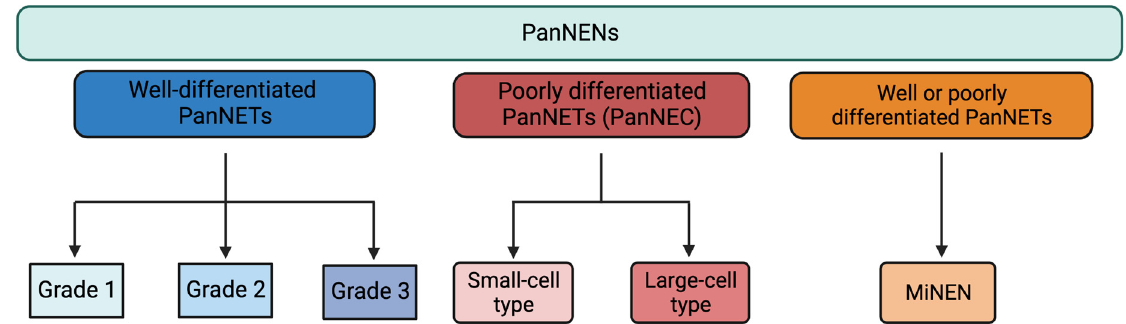
Figure 1. The last WHO’s classification of PanNENs (2019). PanNENs: pancreatic neuroendocrine neoplasms; PanNET: pancreatic neuroendocrine tumor; PanNEC: pancreatic neuroendocrine carci- noma; MiNEN: mixed neuroendocrine/non-neuroendocrine neoplasm. PanNETs are well-differentiated tumors and are classified in G1 (<2 mitotic count/mm 2 ; <3% Ki67 index), G2 (2–20 mitotic count/mm 2 ; 3–20% Ki67 index) and G3 (>20 both mitotic count/mm 2 and % Ki67 index). While PanNECs are poorly differentiated tumors that are always characterized by the mitotic count and Ki67 index of >20